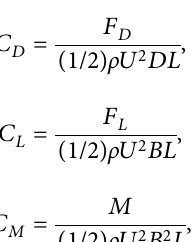
Figure 3: Experimental model in the wind tunnel